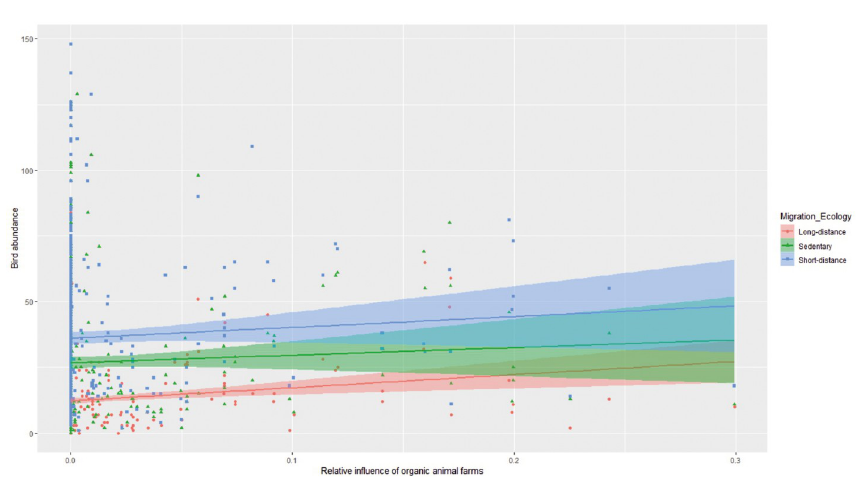
Fig 5. Effects of organic animal farms on bird abundance by migration ecology class. The differential effect of relative influence of organic animal farms (averaged within a 300m radius from each transect line, see Fig 1b) on the summed abundance of birds separated by their main migration ecology (long-distance migrant, short-distance migrant, sedentary, which includes also partial migrant species). Values are based on the original untransformed data. The results of the interaction between relative influence of organic animal farms and birds migration ecology are presented in Table E in S1 File.